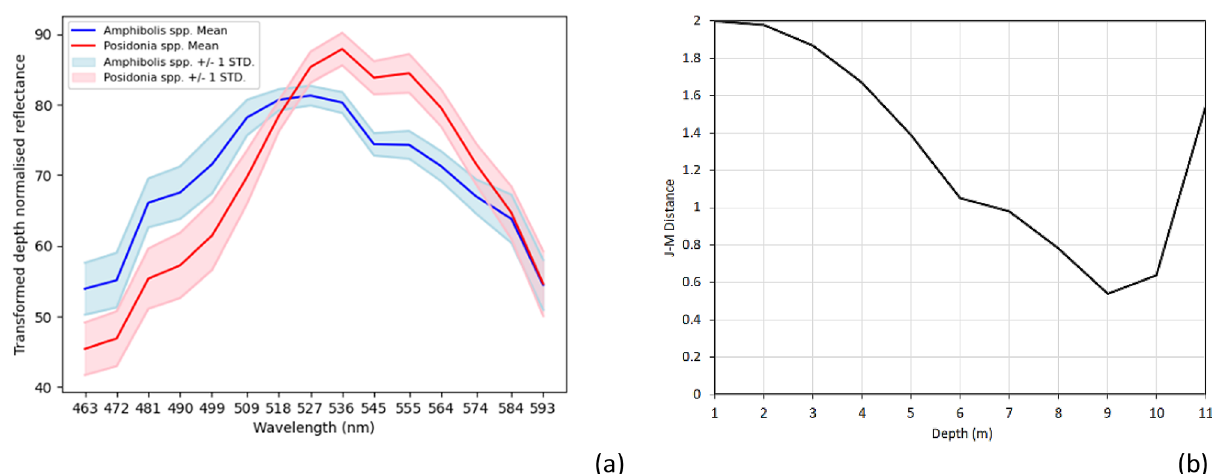
Figure 2. Mean spectral signature of Amphibolis and Posidonia in shallow (1–2 m) waters ( a ), and spectral separability indicated by Jeffries-Matusita (J-M) distance with water depth ( b